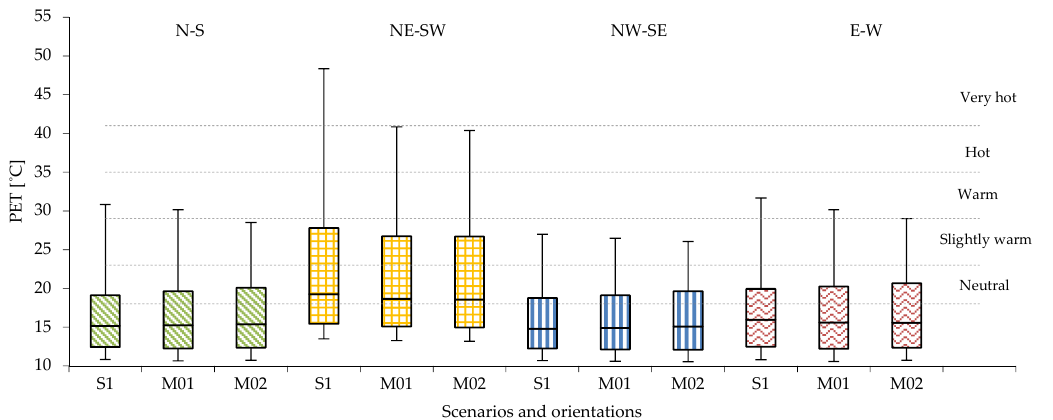
Figure 15. PET values registered in all 14 receptors in the open-set high-rise urban areas for scenario S1, M01 and M02 in all orientations.